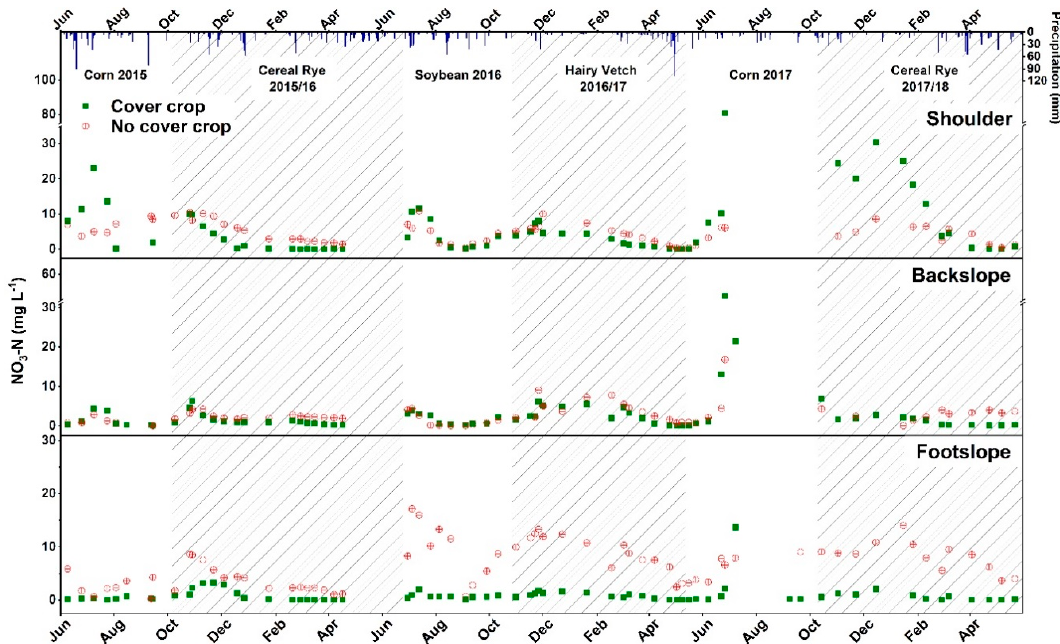
Figure 3. Soil solution nitrate-N (NO 3 -N) concentrations for cover crop and no-cover crop treatments at shoulder, backslope, and footslope topographic positions. Shaded areas indicate the cover crop growing season. Bars at the top of the figure represent daily precipitation received at the research site.